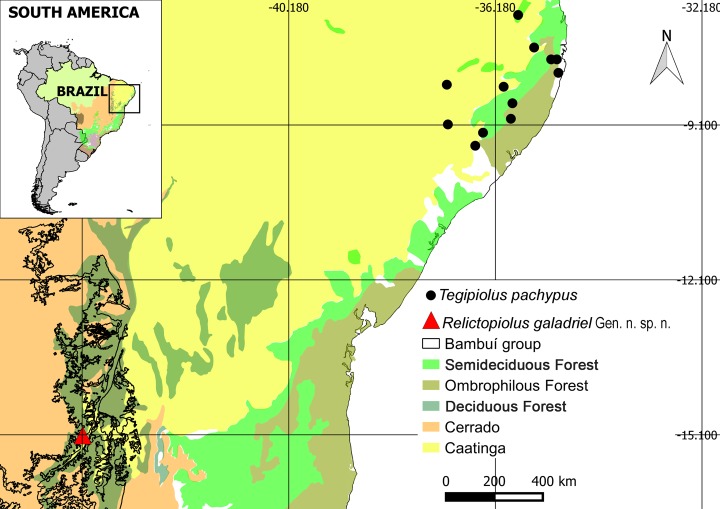
Current distribution of Relictopiolus galadriel gen. nov., sp. nov. (triangle) and Tegipiolus pachypus Roewer, 1949 (dots).The vegetation types (sensu the vegetational classification system proposed by the Instituto Brasileiro de Geografia e Estatística [37]) are delimited by color.